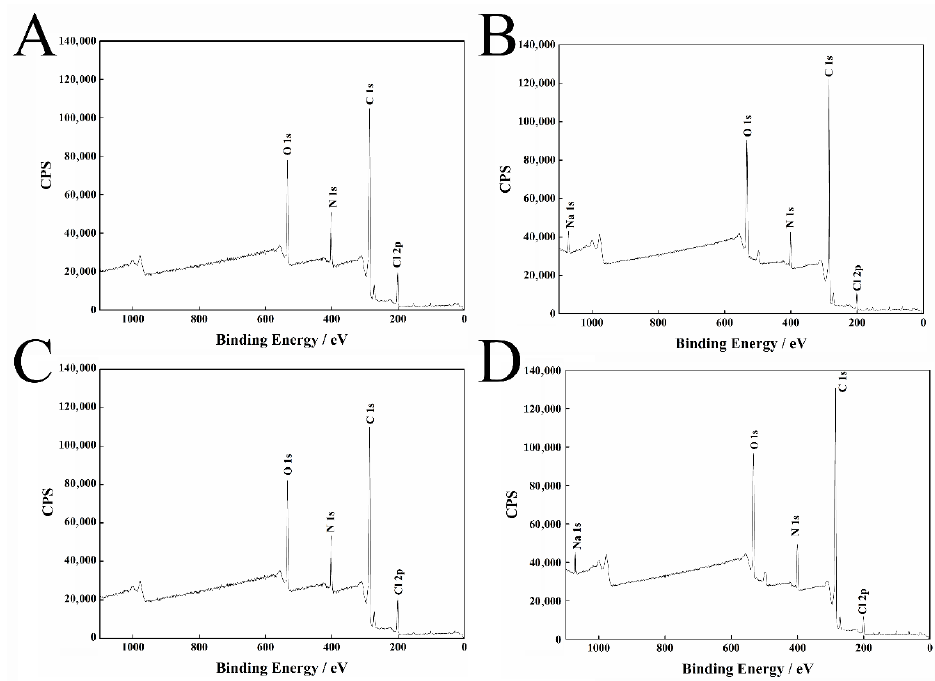
Figure 6. XPS results of pyraclostrobin crystal II ( A ), adsorbed dispersant 2700 ( B ), pyraclostrobin crystal IV ( C ) and adsorbed dispersant 2700 ( D ). Table 4. Electron bonding energy and concentration of each element in pyraclostrobin crystal II with adsorbed 2700.